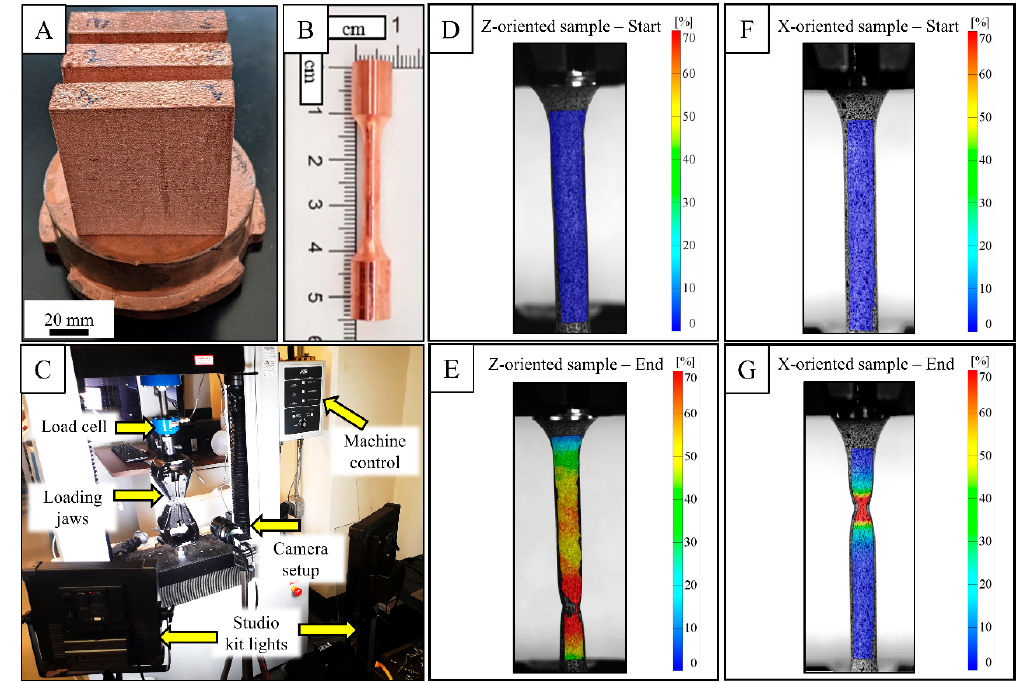
Figure 2. Fabricated blocks on a copper substrate ( A ), Machined tensile sample according to [33] ( B ), Overall tensile test setup showing the arrangement of DIC camera and lighting kits ( C ), Strain mapping of a Z- and X-oriented vacuum-annealed tensile sample in GOM Correlate software in the beginning ( D , F ) and the end ( E , G ) of the test, respectively.